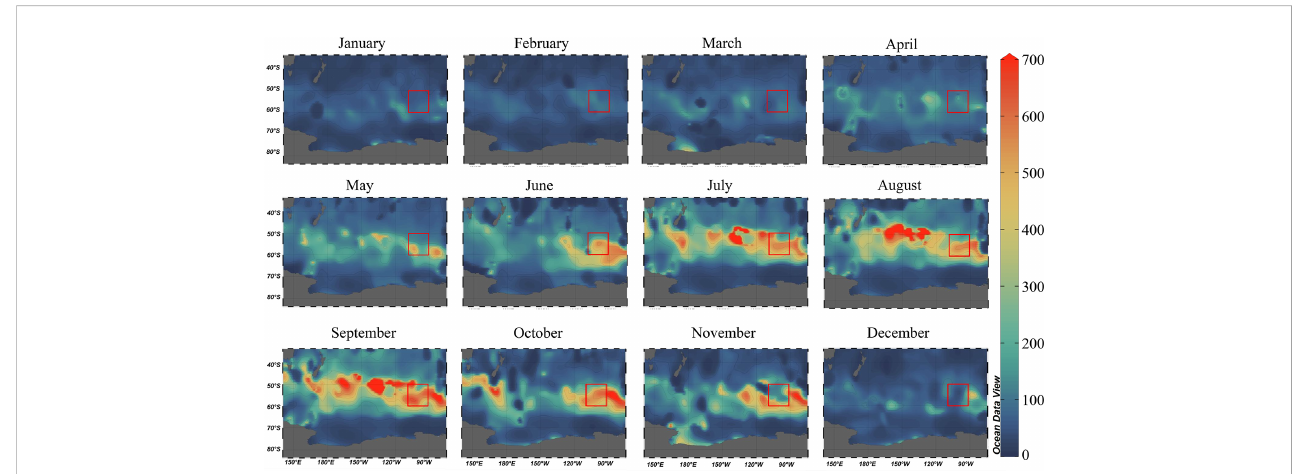
FIGURE 4 Modeled mixed layer depths from Monterey and Levitus, 1997. Mixed layer depths are calculated as the fi rst depth in which potential density exceeds 0.125 kg m -3 of the surface density. The embedded red boxes indicate the approximate latitudes in which the widespread export event of 2017 had